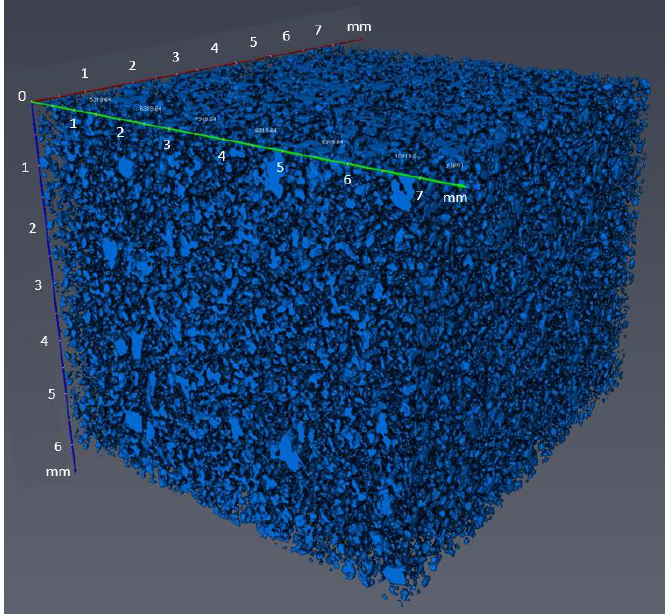
Figure 3. Reconstructed 3-D CT images of pore structure with sample size of 6 mm × 7 mm × 7 mm (pores are shown in blue).